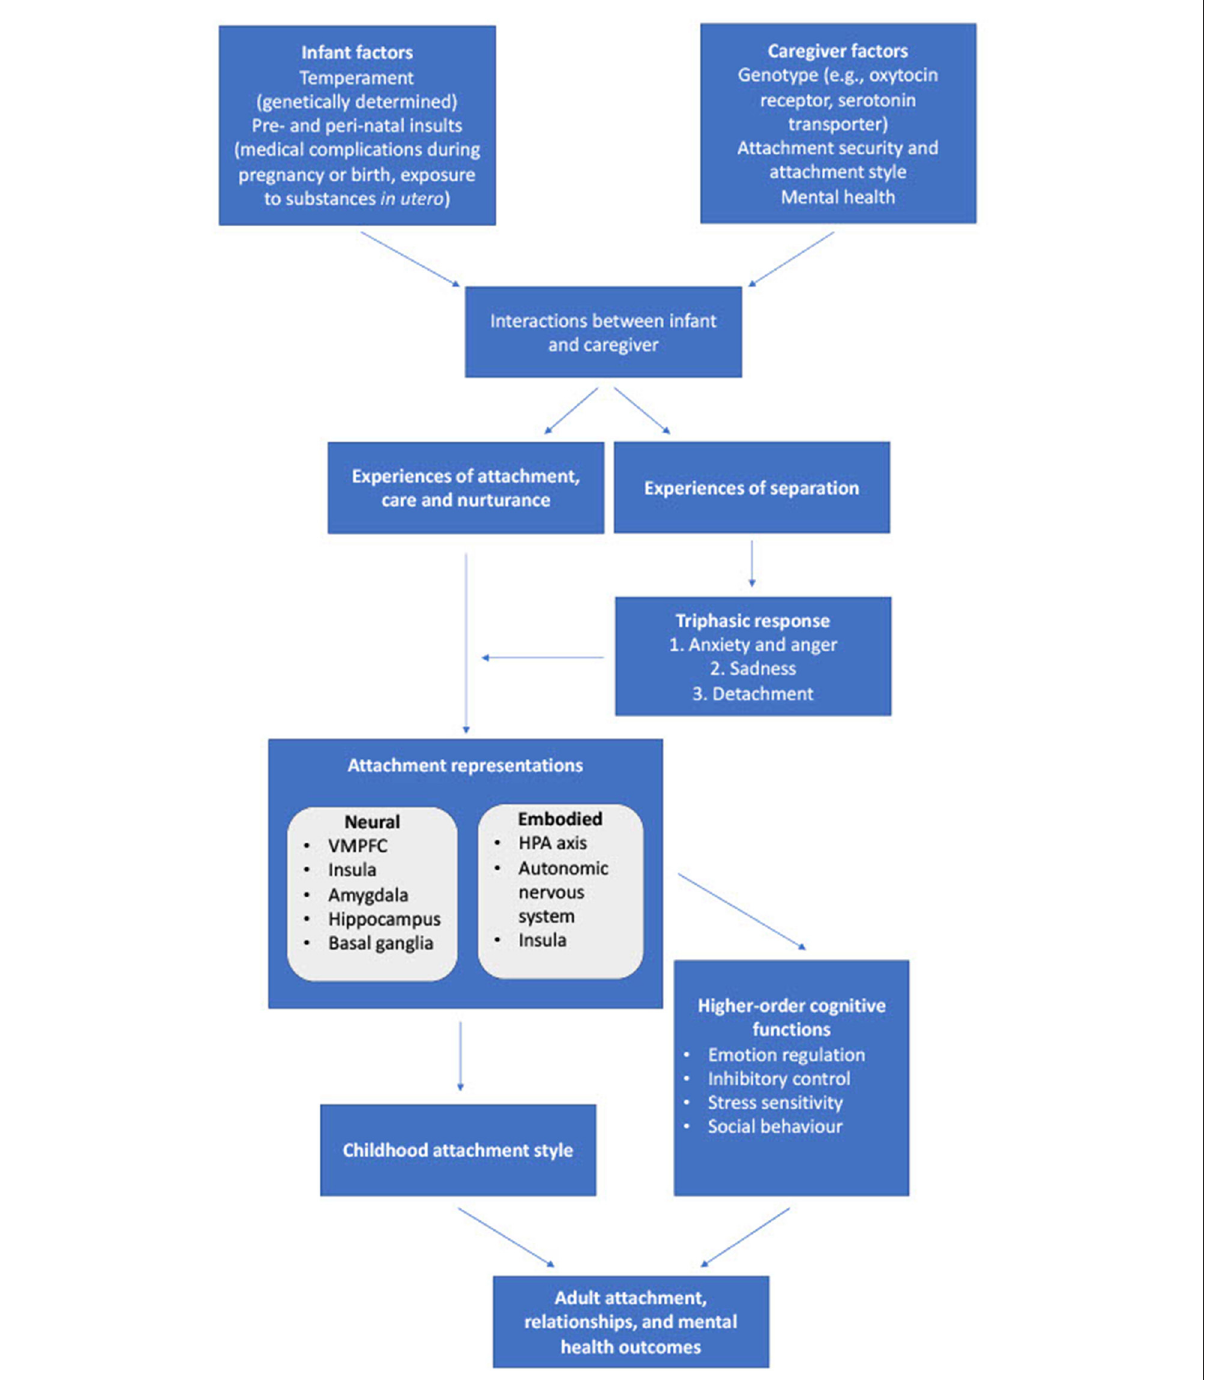
FIGURE1 Processes involved in childhood attachment, their physiological correlates, and their effects on cognition and adult outcomes. VMPFC, ventromedial prefrontal cortex; HPA,